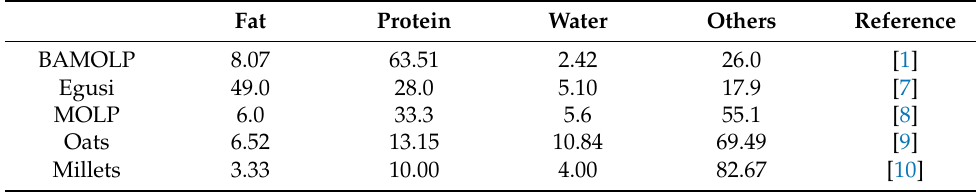
Table 1. Proximate composition of ingredients.